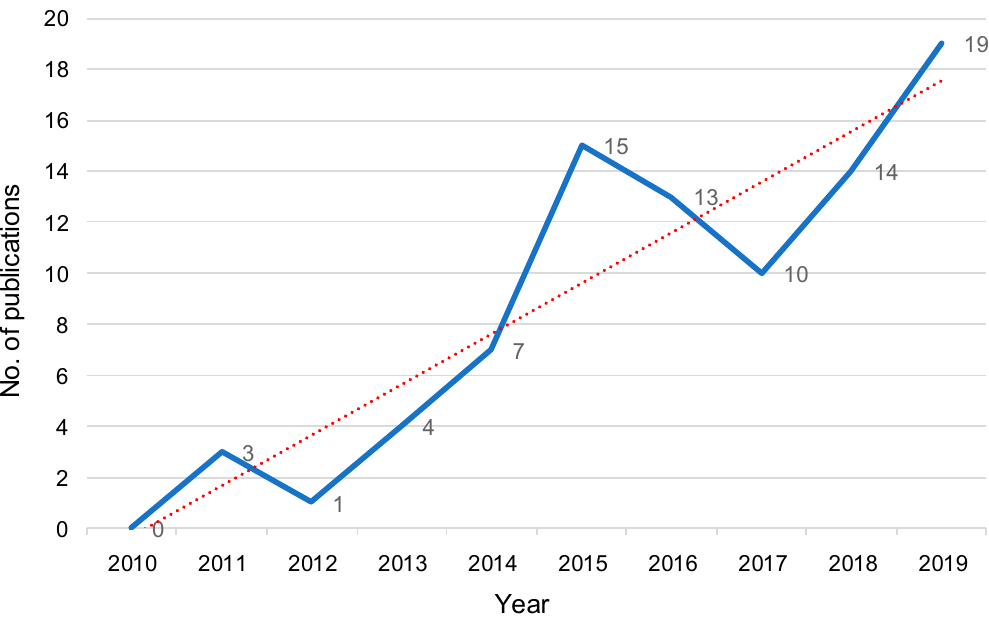
Figure 2. Temporal allocation of the selected publications (the dotted red line represents the linear tendency, while the solid blue line follows the number of publications per year).